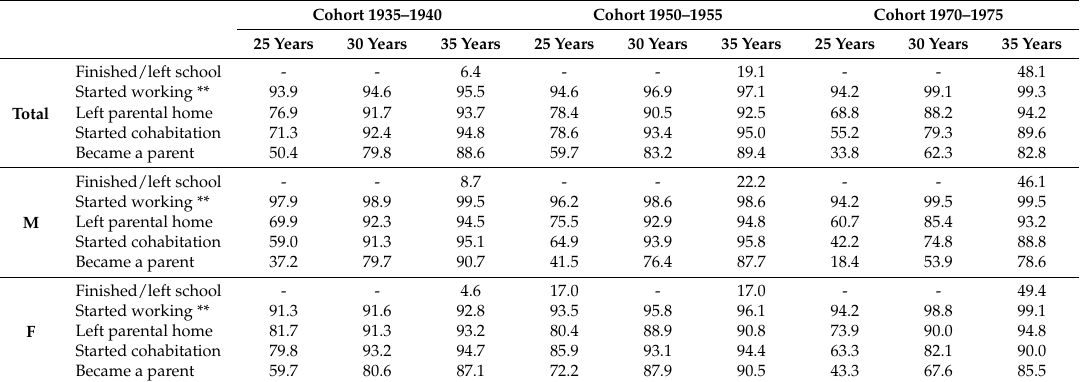
Table 5. Percentage of individuals that completed a transition at three age